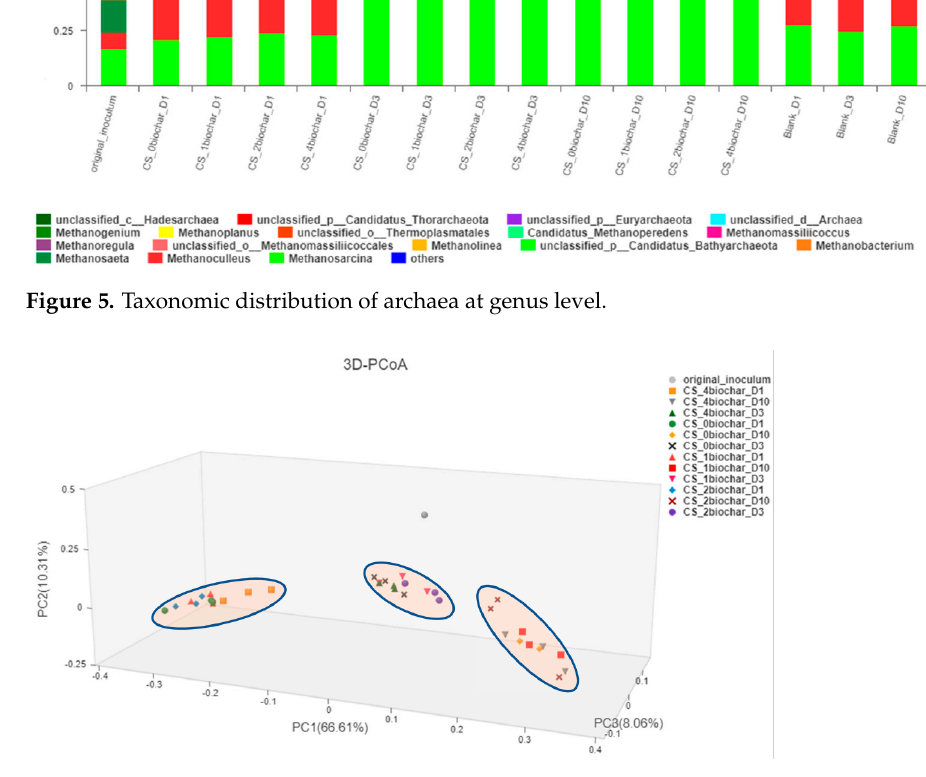
Figure 6. 3D-Principal coordinates analysis (PCoA) biplots of Bray-Curtis distances of archaea during